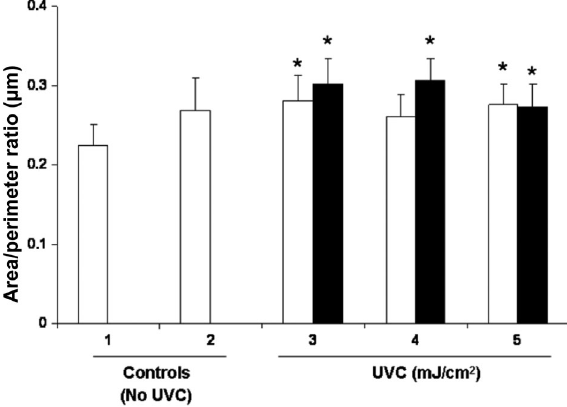
Figure 2. Area-perimeter ratio of exponential Escherichia coli AB1886 cells pre-exposed to a low intensity red laser and UVC radiation. 1 ) Non-irradiated control, 2 ) red laser at 8 J/cm 2 , 3 ) UVC at 25 mJ/cm 2 (white bar) and red laser at 8J/cm 2 + UVC at 25 mJ/cm 2 (black bar), 4 ) UVC at 50 mJ/cm 2 (white bar) and red laser at 8 J/cm 2 + UVC at 50 mJ/cm 2 (black bar), and 5 ) UVC at 100 mJ/cm 2 (white bar) and red laser at 8 J/cm 2 + UVC at 100 mJ/cm 2 (black bar). Experiments were performed in duplicate and the results are reported as means ± SD of three independent assays. *P o 0.05, compared to control 1 (non-irradiated cells) (one-way analysis of variance, followed by Tukey ’ s post hoc